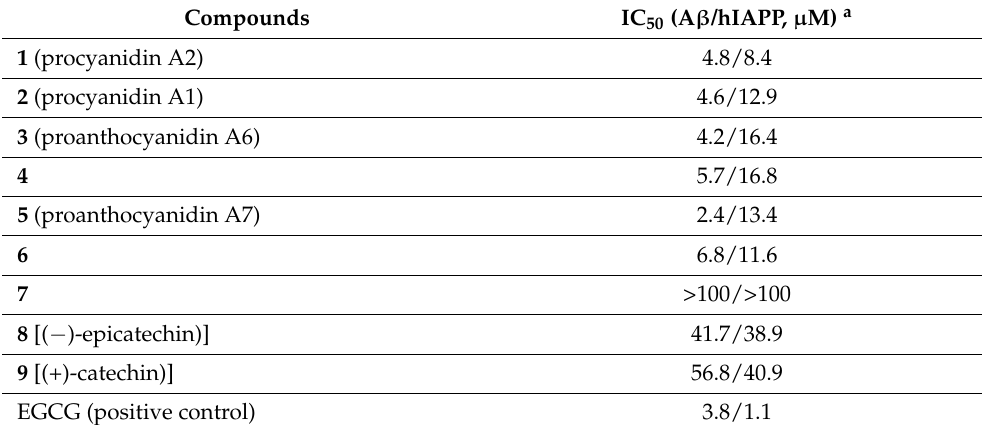
Figure 2. Efficacy of compounds 1 , 3 , 5 , 7 , and 8 against A β 42 aggregation. A β 42 (25 μ M) fibril formation was monitored by Th-T fluorescence with varying concentrations of these compounds.